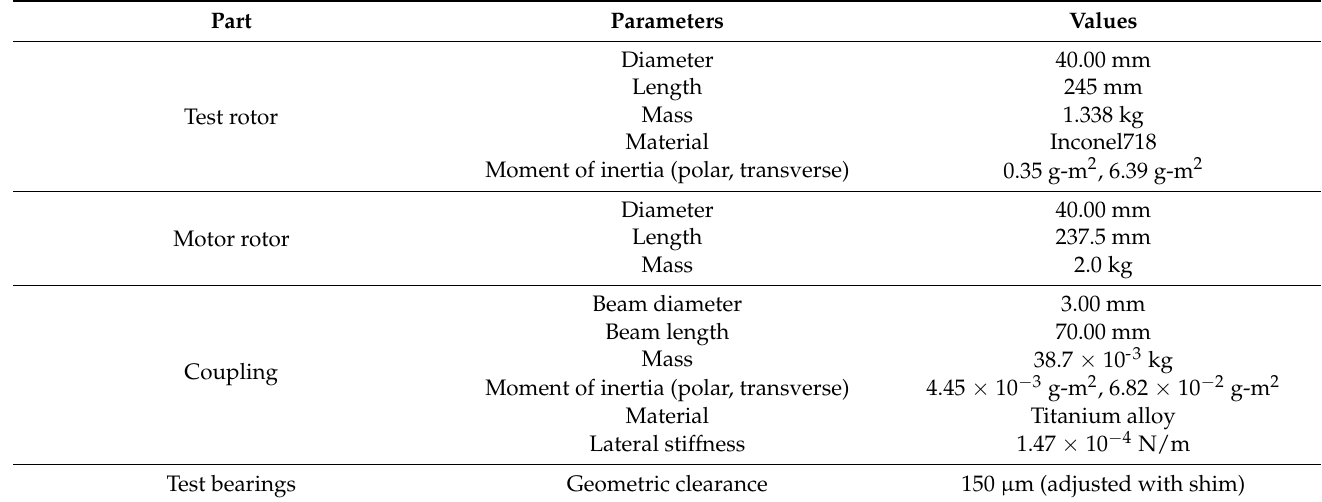
Table 2. Design parameters of the dual-rotor rotordynamic test